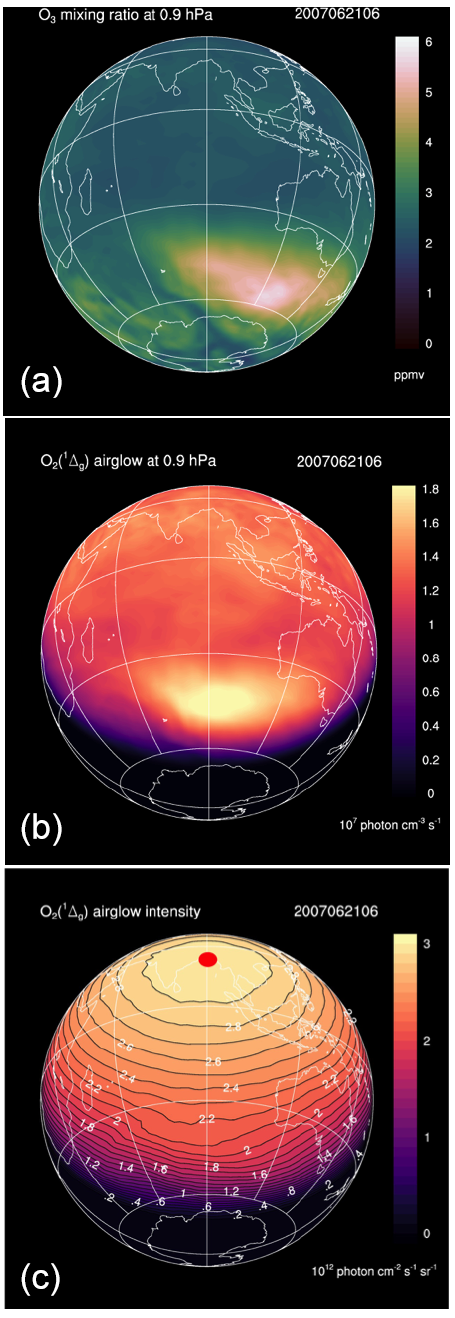
Figure 10. Simulations of the REPROBUS model for 21 June 2007 at 06:00UT. This is the geographical distribution of three relevant quantities with their colour code. (a) Ozone mixing ratio (ppmv) at 0.9hPa (about 50km). (b) Volume emission rate of O 2 ( 1 (cid:49)) at 0.9hPa in units of 10 7 photonscm − 3 s − 1 . (c) Integrated vertical in- tensity of O 2 ( 1 (cid:49)) in units of 10 12 photonscm − 2 s − 1 sr − 1 . Because of the particular time and date, the sub-solar point is at a latitude of 23.5 ◦ N and on the meridian of 90 ◦ E, which is the red spot plotted in the centre of panel (c)